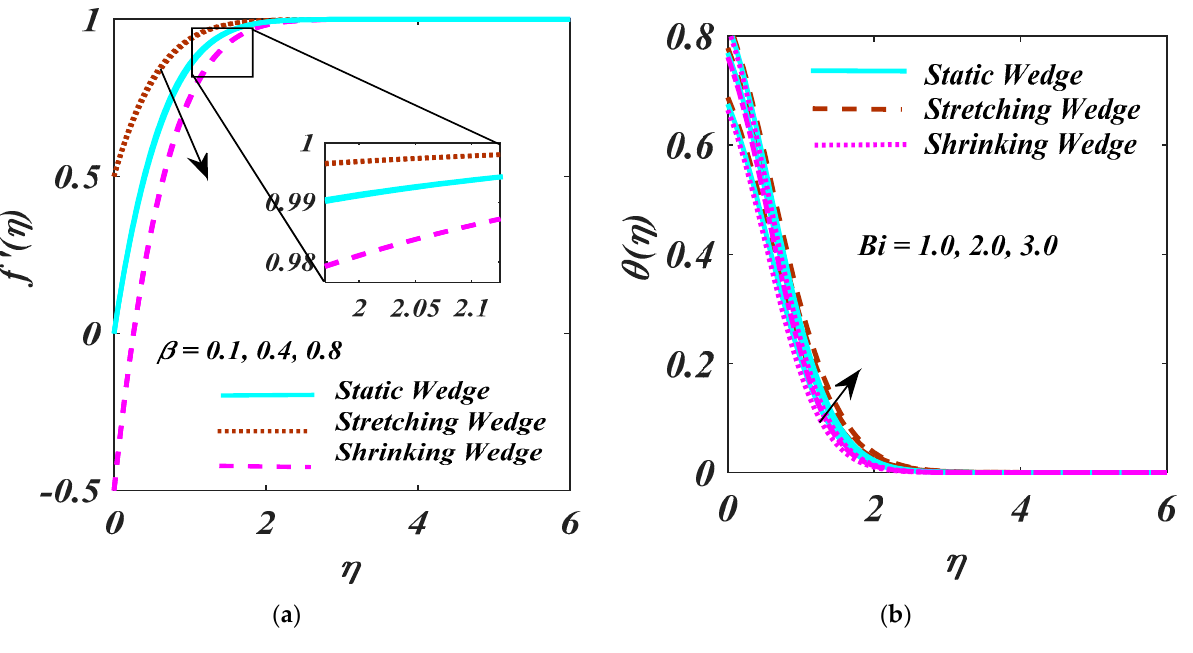
Figure 5. ( a , b ) f (cid:48) ( η ) and θ ( η ) impact on β and Bi .